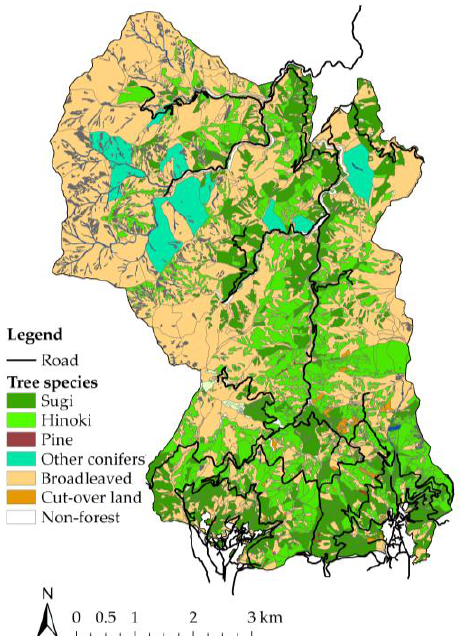
Figure 8. Tree species and forest roads in the study area.